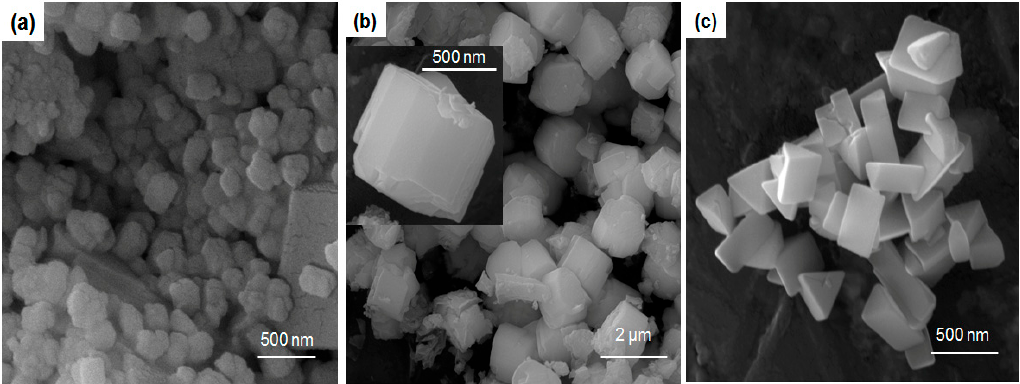
Figure 2. Field emission scanning electron microscopy (FESEM) representations of the samples ( a ) LC-1, ( b ) LC-2, and ( c ) LC-3. The inset in (b) shows a high-magnification image of the sample LC-2.